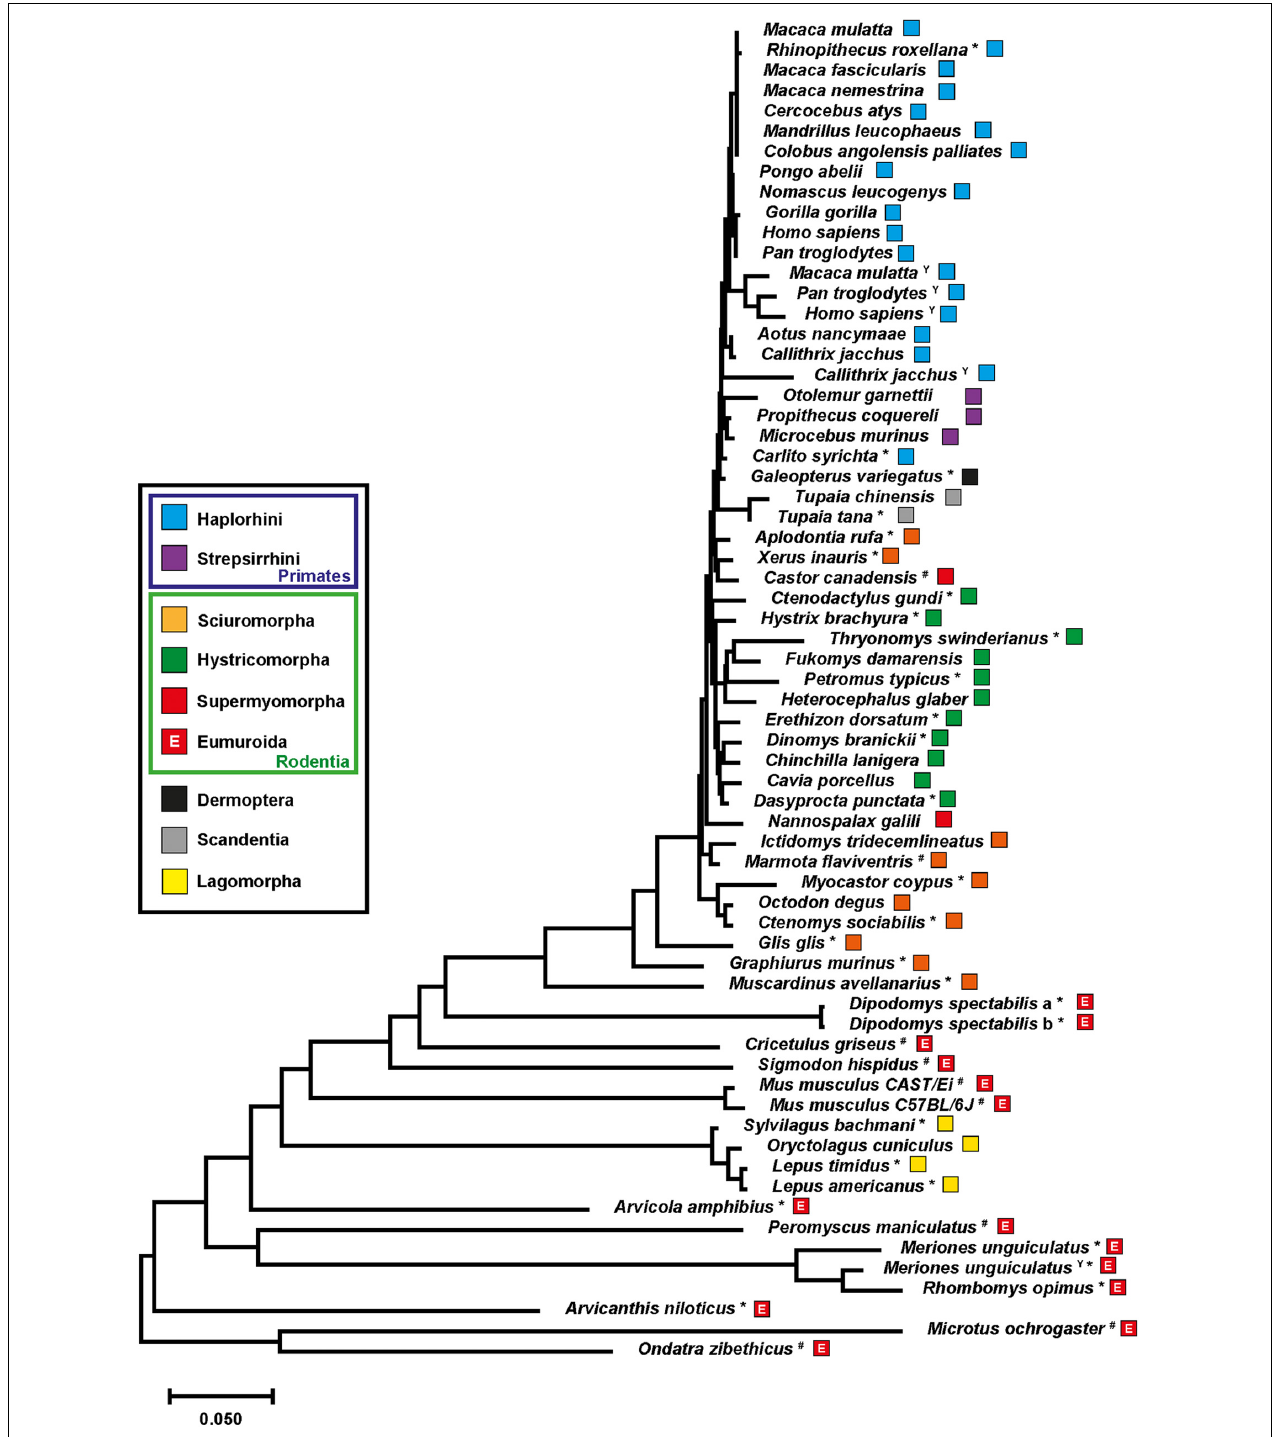
FIGURE 3 | Evolution of neuroligin-4 within the superorder euarchontoglires. The evolutionary history of neuroligin-4 was inferred using the Neighbor-Joining method (Saitou and Nei, 1987). For this tree 66 neuroligin-4 protein sequences representing all five orders classified under the superorder euarchontoglires (Murphy et al., 2001), i.e., dermoptera, lagomorpha, primates, rodentia and scandentia, were aligned and the resulting optimal tree (branch length ∼= 3.29) is shown. Numbers of bootstrap replication (1,000) test are depicted in Supplementary Figure 3 ; Felsenstein, 1985). The tree is drawn to scale, with branch lengths in the same units as those of the evolutionary distances used to infer the phylogenetic tree. The evolutionary distances were computed using the Poisson correction method